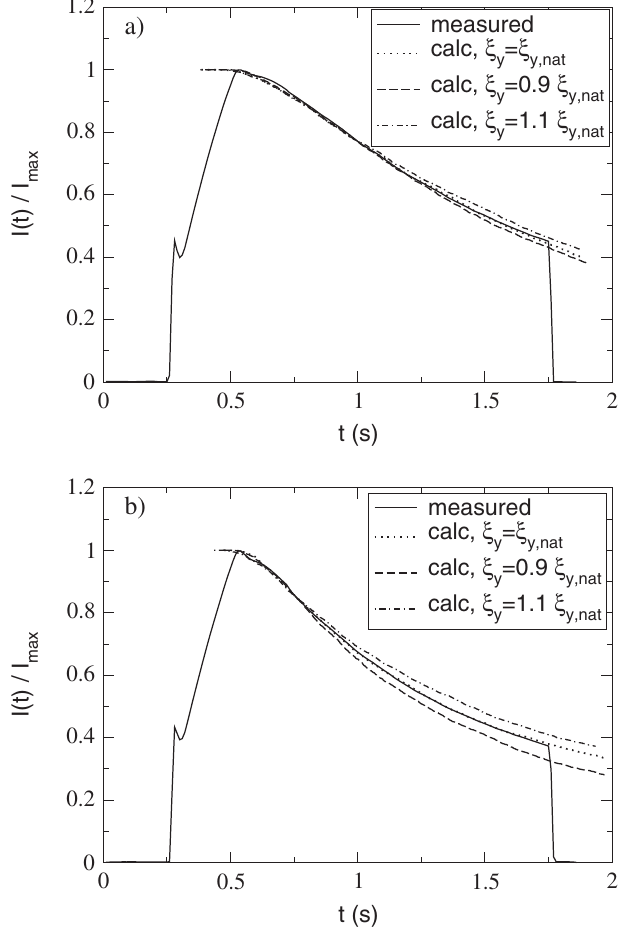
FIG. 4. Current as a function of time measured and computed ¼ 29 V . In graph (a), the half width of the power for U a ¼ 0 : 01 =T 0 and the spectrum of the exciter [Eq. (26)] is f S ¼ 0 : 005 =T 0 acceptance is (cid:3) lim ¼ 46 mm mrad . In graph (b), f S and (cid:3) lim ¼ 45 mm mrad are used. For both graphs the chroma- ticity has been varied by (cid:8) 10% in the simulations. The resulting modifications of the beam current I ð t Þ at t ¼ 1 : 75 s are þ 4 : 5% and (cid:1) 2 : 7% , respectively, in graph (a) and þ 7 : 2% and (cid:1) 14 : 5% , respectively, in graph